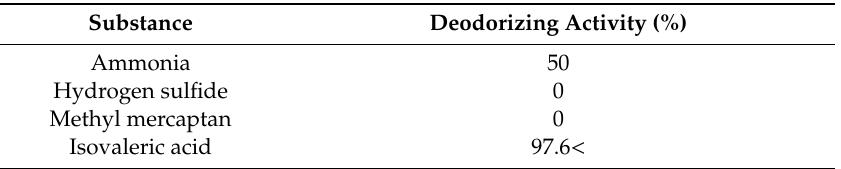
Table 2. Deodorizing e ff ect of kuromoji essential